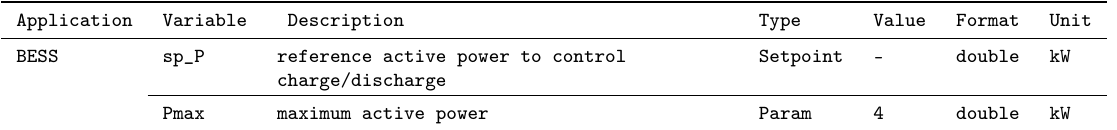
Table 13. Battery model created by a control engineer.